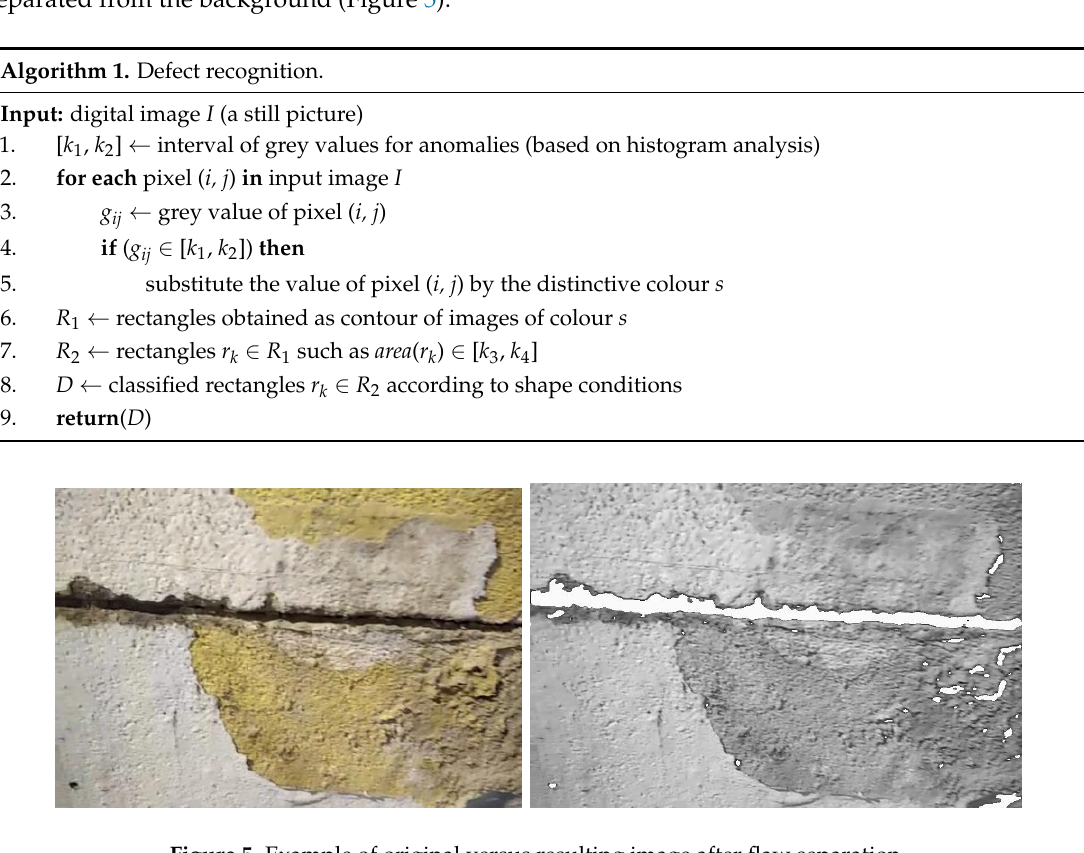
Figure 6. Example of image classification.